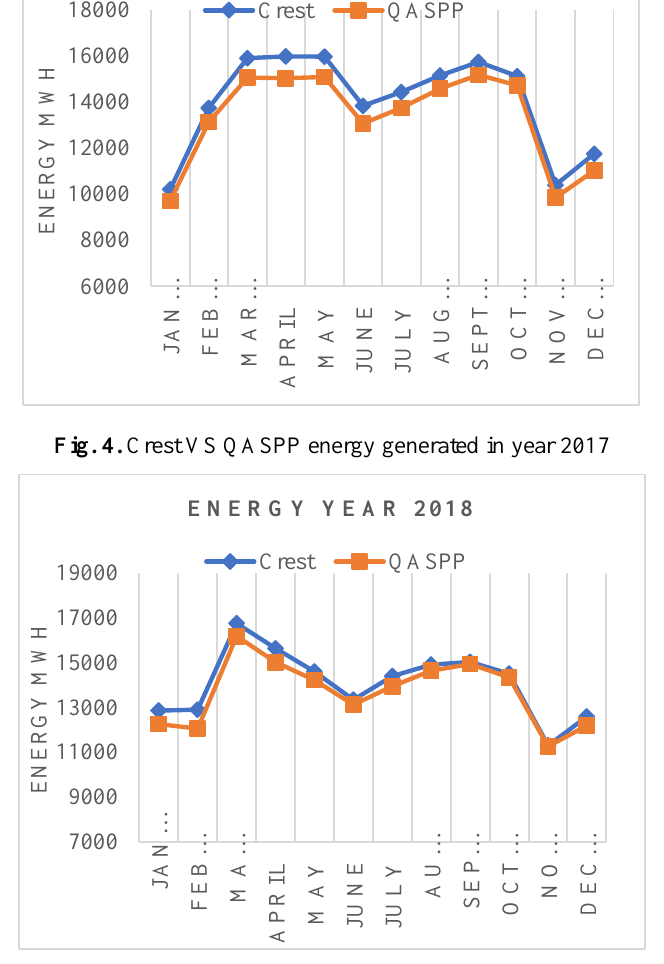
Fig. 5. Crest VS QASPP energy generated in year 2018